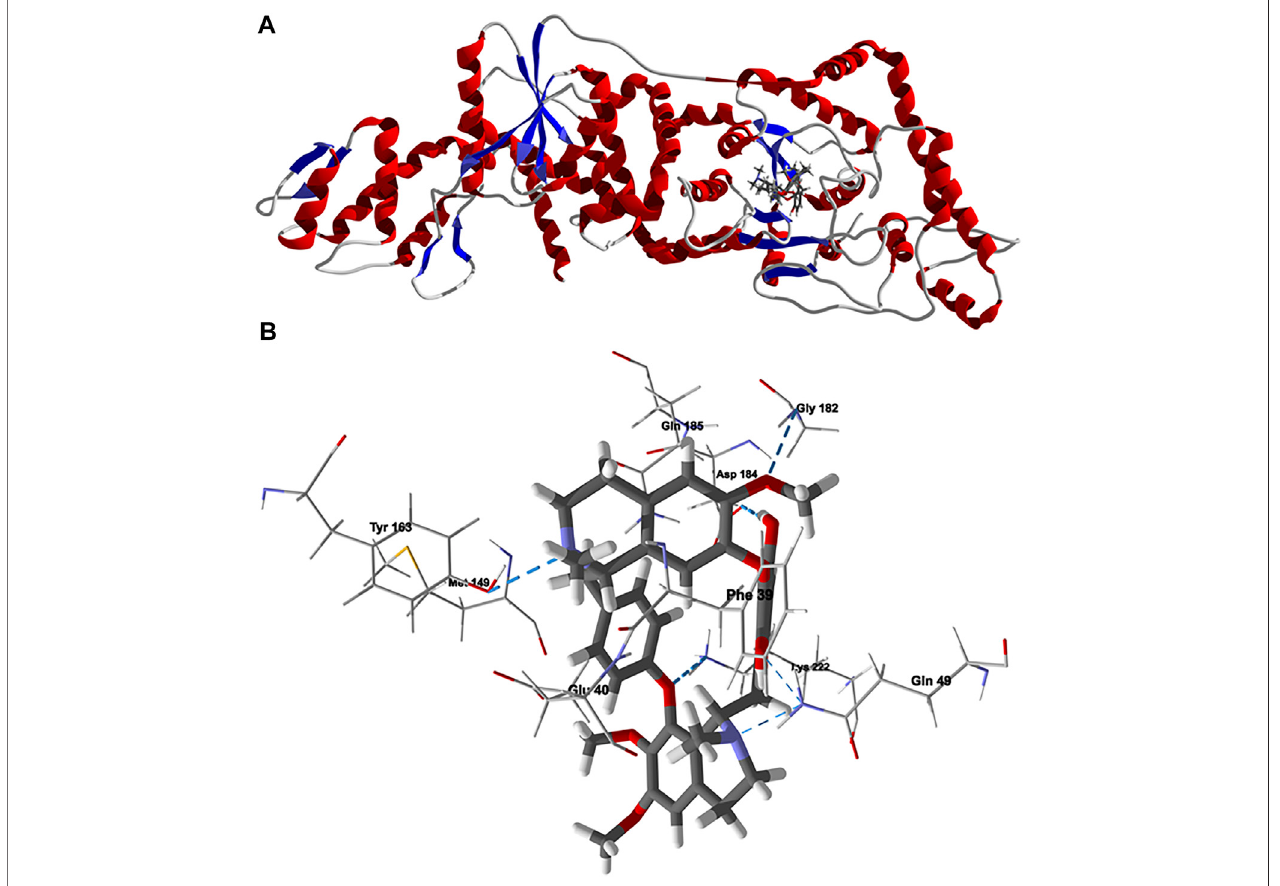
FIGURE 8 | Lowest-energy docked pose of chondrofolinol with Leishmania major tyrosyl-tRNA synthetase (Lmaj TyrRS, PDB 3P0J). (A) : Ribbon structure (the docked chondrofolinol is shown as a stick fi gure). (B) : Active site showing the interactions of important contacts in the active site with the docked ligand (hydrogen- bonded interactions are indicated with blue dashed